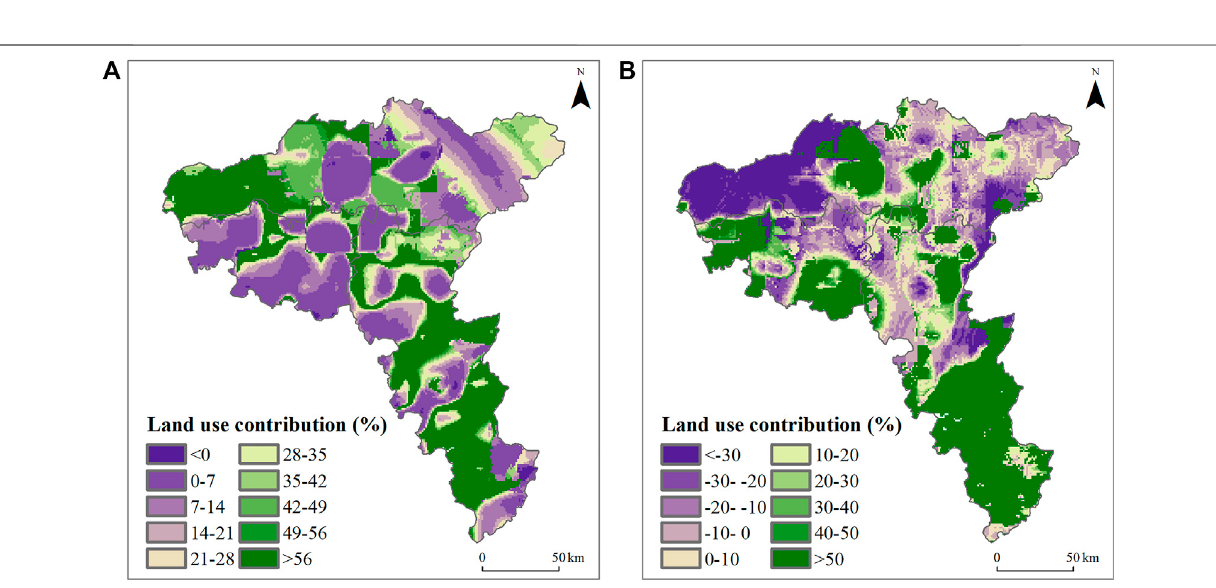
Frontiers in Environmental Science |